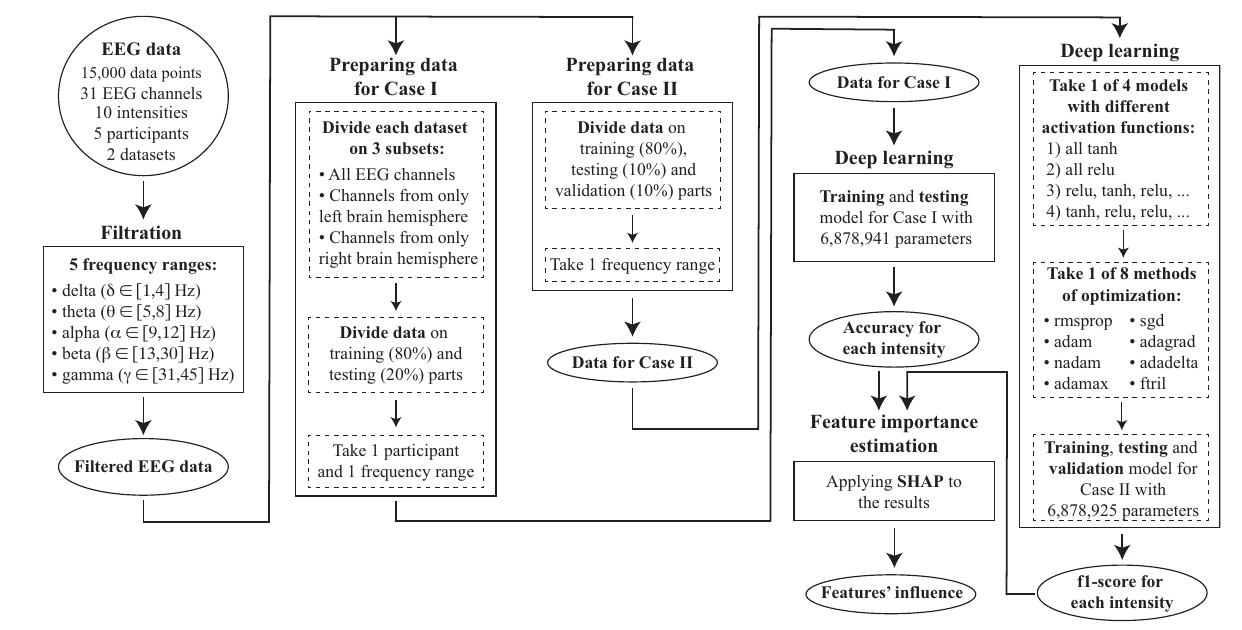
Figure 3. Schematic representation of overall structure. Rectangle frames depict steps of data analysis, oval frames correspond to the input/output data for each